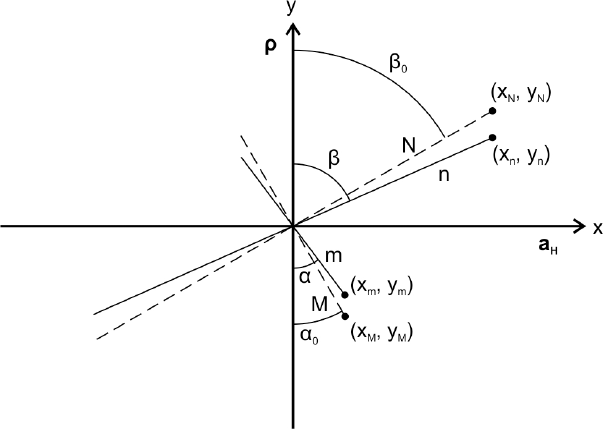
Figure A5. Relationship between angles of length m and breadth n of fossil 3 in Fig. 2b and their undeformed counterparts M and N